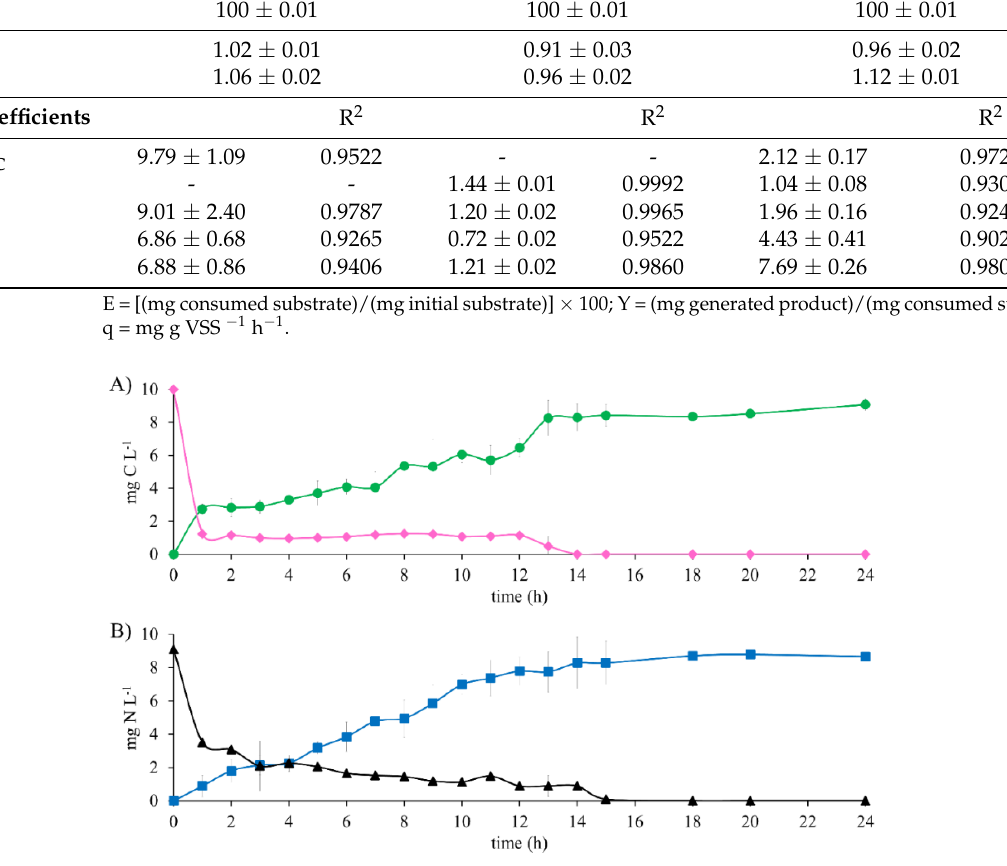
Figure 2. Substrate consumption profile and generation of denitrifying assay products with 10 mg E2-C L −1 at C N −1 of 1.1. ( A ) Carbon compounds: ( ♦ ) E2-C, ( ● ) HCO 3 − -C. ( B ) Nitrogen compounds: ( ▲ ) NO 3 − -N, ( ■ ) N 2 .